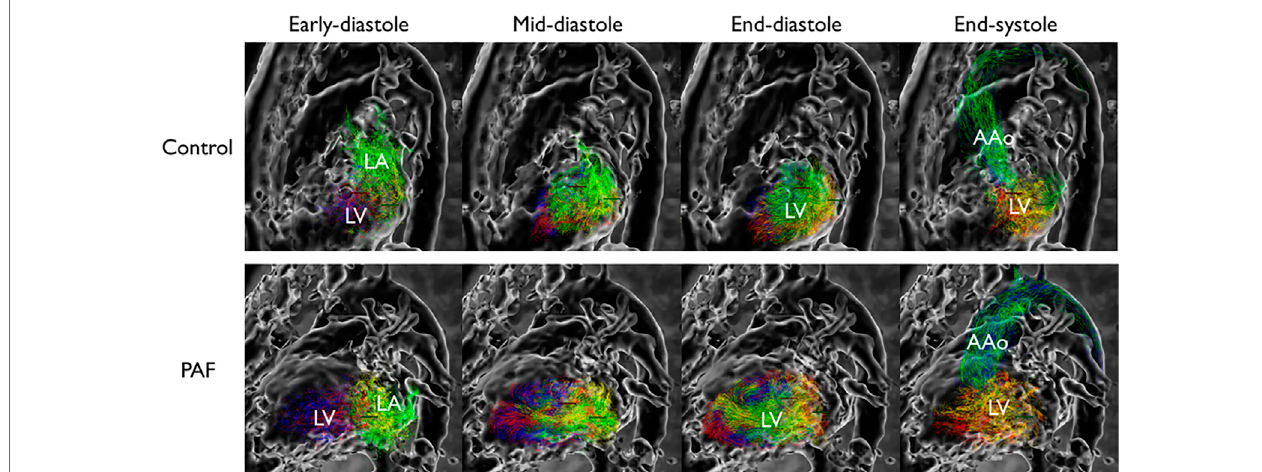
FIGURE 3 | Flow pattern example in left ventricle. Each component is color-coded; green: direct fl ow, yellow: retained in fl ow, blue: delayed ejection, red: residual volume. Reduced proportion of direct fl ow is observed at end-diastolic phase in PAF. LA indicates left atrium; LV, left ventricle; and AAo, ascending aorta.